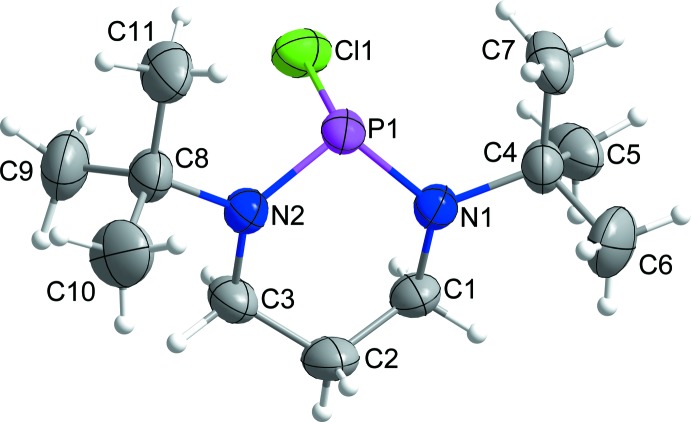
Diagram of the mol­ecular structure of compound 1 in the crystal displaying the atom-labelling scheme. Anisotropic displacement ellipsoids are drawn at the 50% probability level, the radii of hydrogen atoms are chosen arbitrarily.